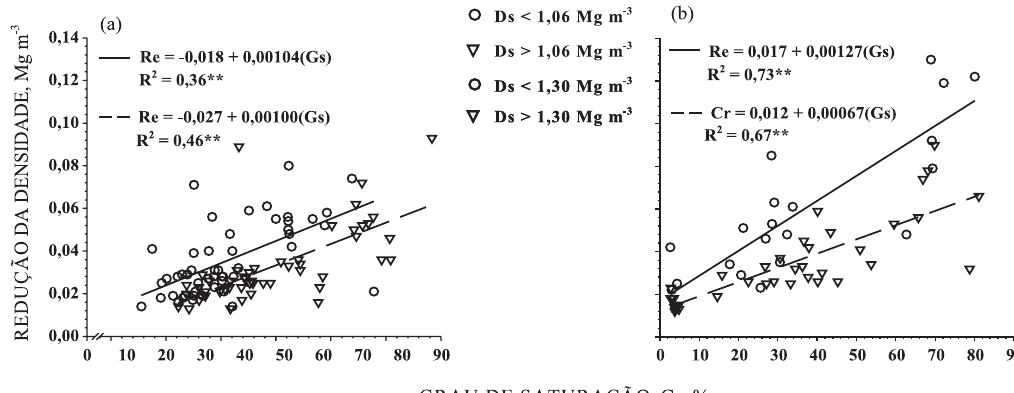
Figura 3. Redução da densidade do solo ( Rebound ) após o descarregamento, em função do grau de saturação com água de um Nitossolo Vermelho distrófico latossólico (a) e de um Argissolo Vermelho-Amarelo distrófico arênico (b), para duas classes de